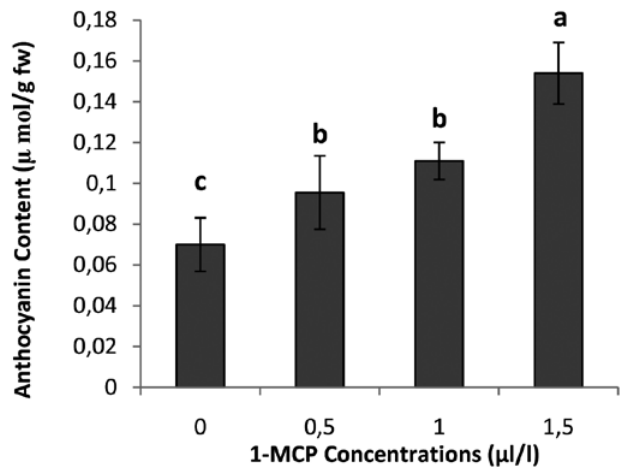
Fig. 4 - Effect of 1-MCP on petal anthocyanin content of carnation cv. Fortune. Data are means with standard errors